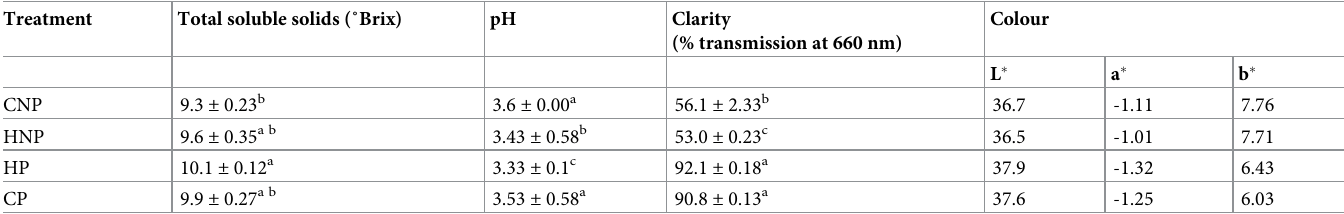
Different letters in the same column indicate significant differences at p < 0.05. Data are reported as mean ± standard deviation (n = 3). L (cid:3) , a (cid:3) , b (cid:3) CIE colour values showing colour change of Strychnos cocculoides juice per treatment CNP: Cold water extraction without pectinase, HNP: Hot water extraction without pectinase, HP: Hot water extraction with pectinase, CP: Cold water extraction with